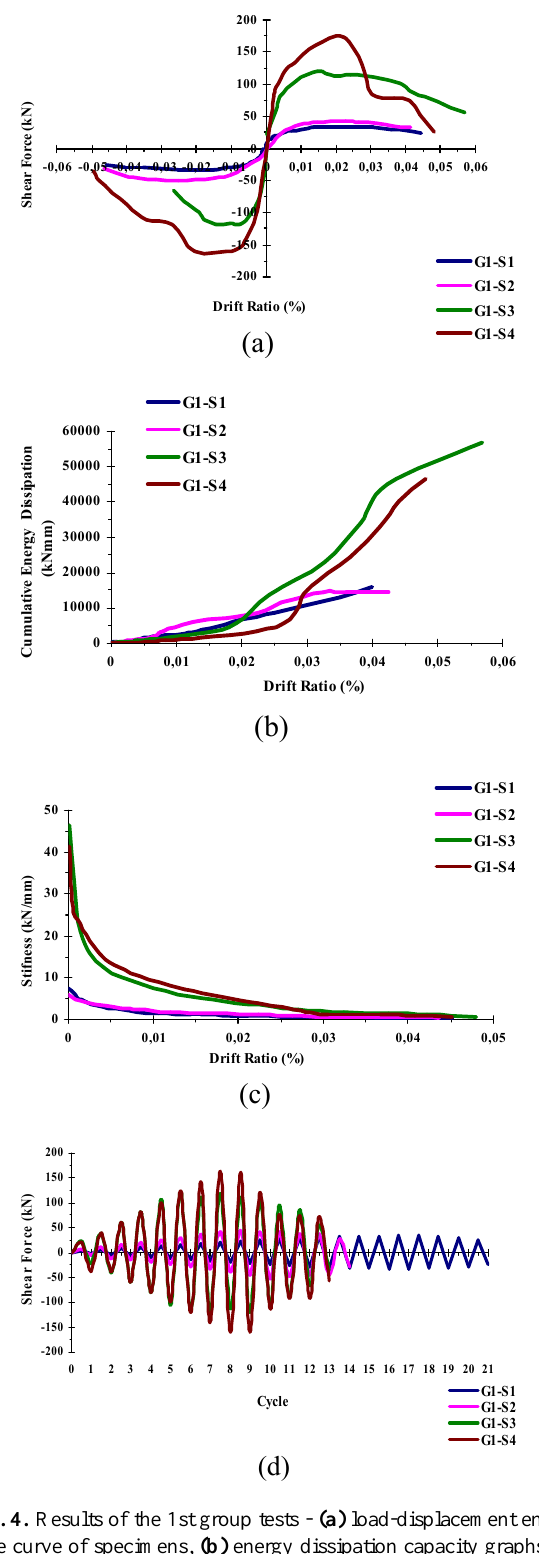
Fig. 4. Results of the 1st group tests - (a) load-displacement enve- lope curve of specimens, (b) energy dissipation capacity graphs of Figure 4. Results of the 1 st group tests – (a) Load–displacement envelope curve of specimens specimens, (c) stiffness characteristics of specimens, (d) load histo- ries of specimens.